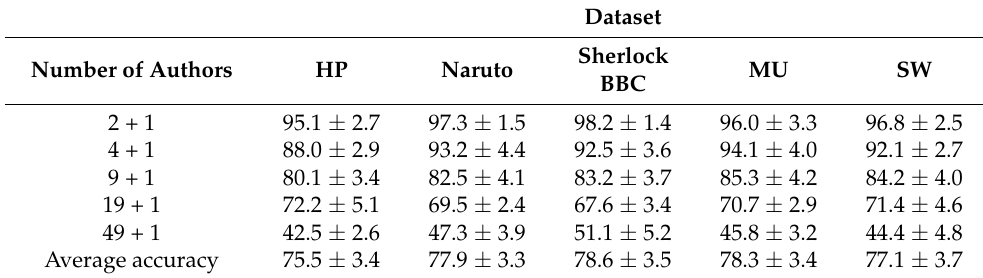
Table 14. One-Class SVM + fastText for in-group classification.